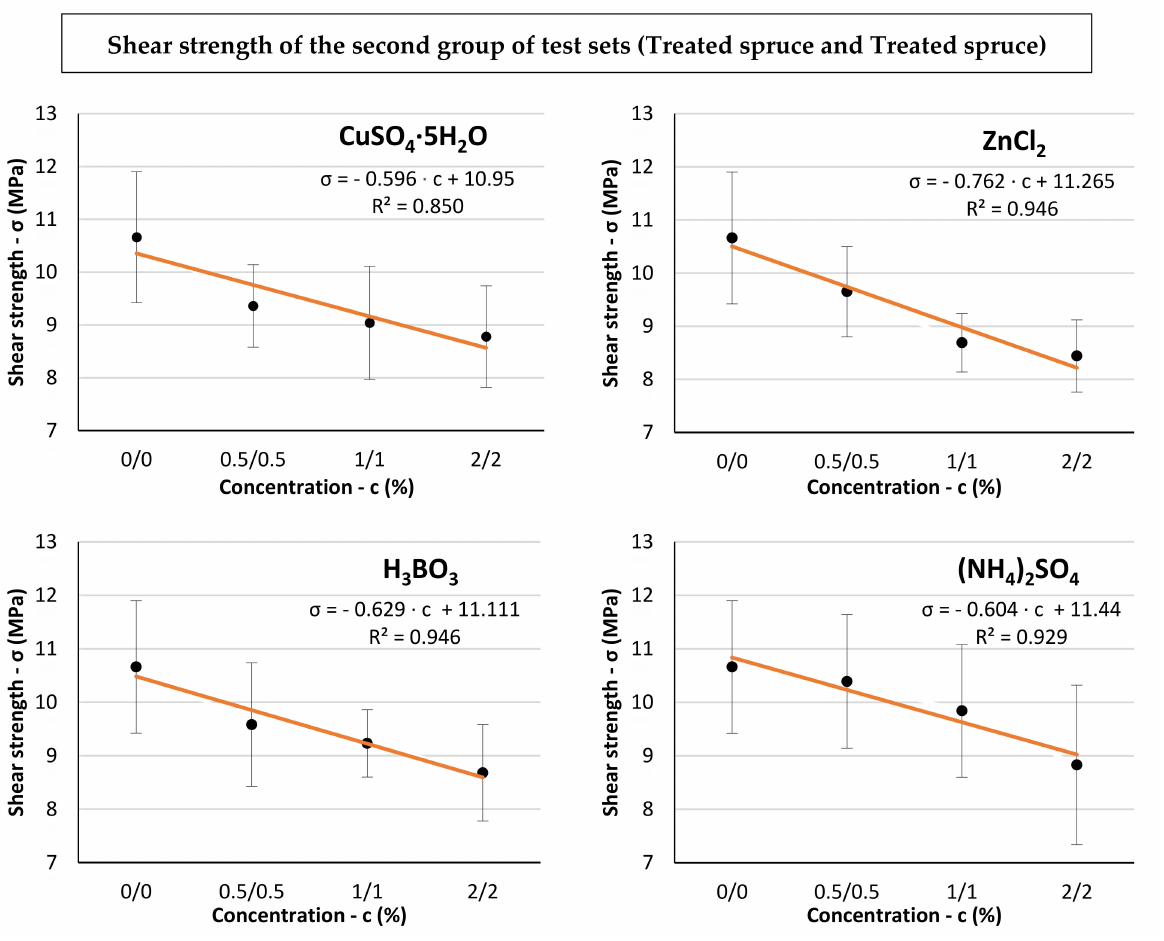
Figure 4. Linear dependencies between the shear strength of glued joints ( σ ) and the concentration of a preservative (c) in the second group of test sets “Treated spruce and Treated